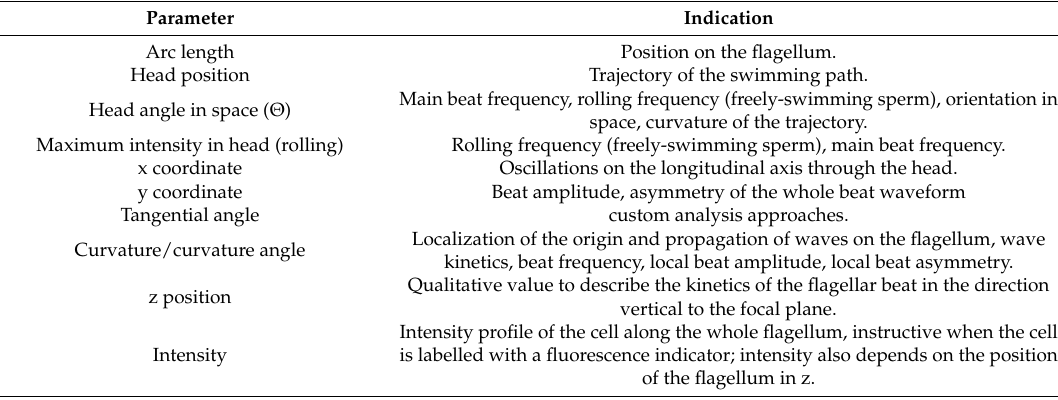
Table 2. Terminology and indications of SpermQ parameters. Indication Position on the flagellum. Head position Trajectory of the swimming